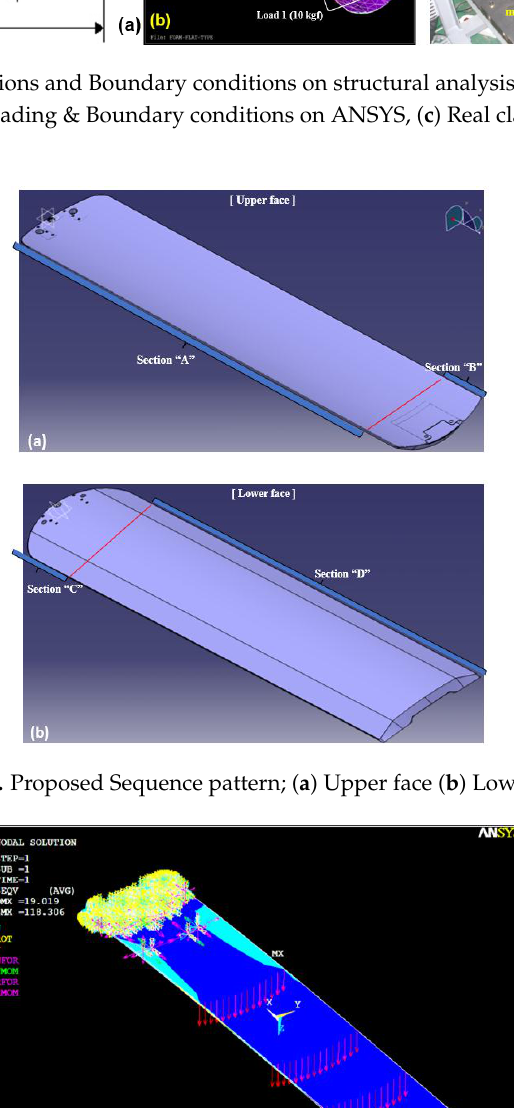
Figure 8. Proposed Sequence pattern; ( a ) Upper face ( b ) Lower face.